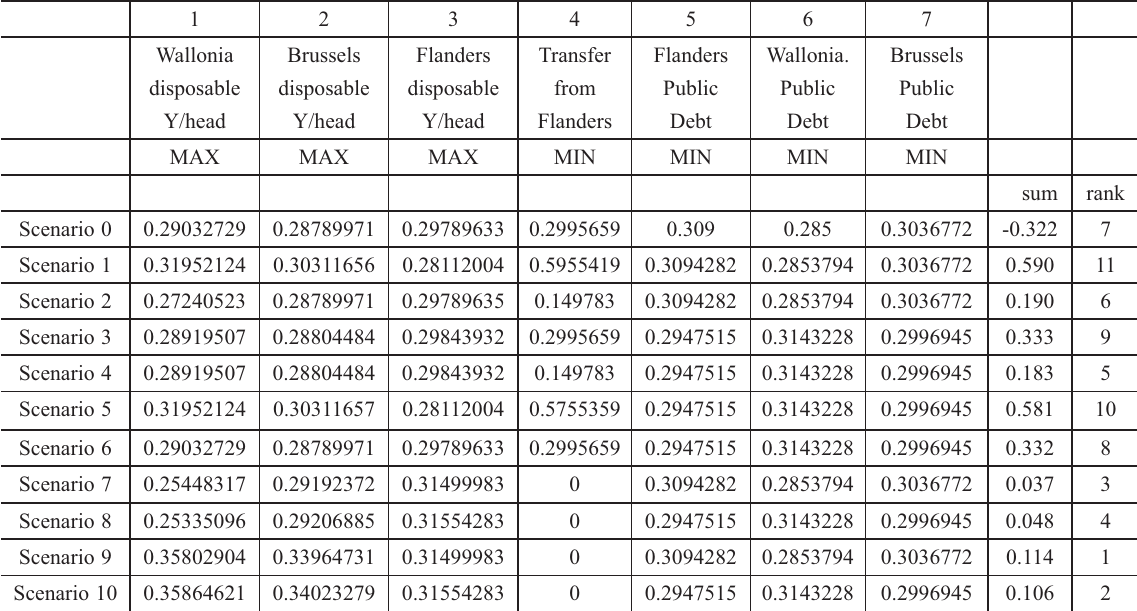
Table 9. Reference Point Part with a significance coefficient of 2 for the private incomes 9c. Objectives divided by their square